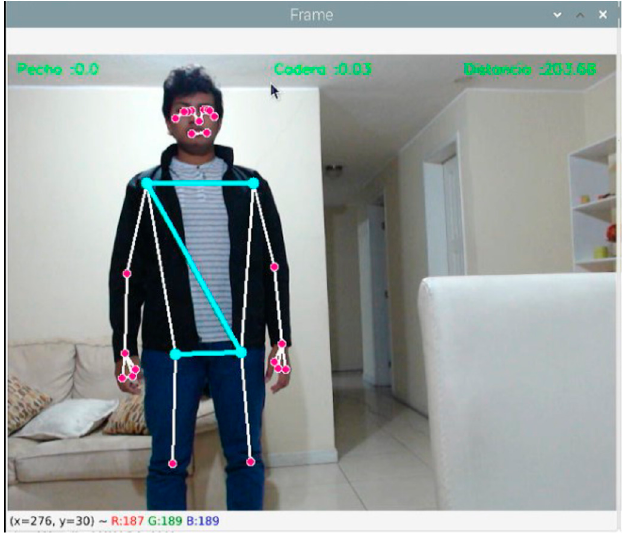
Figure 2. Skeletonization of a person for the detection of positions with reference points.